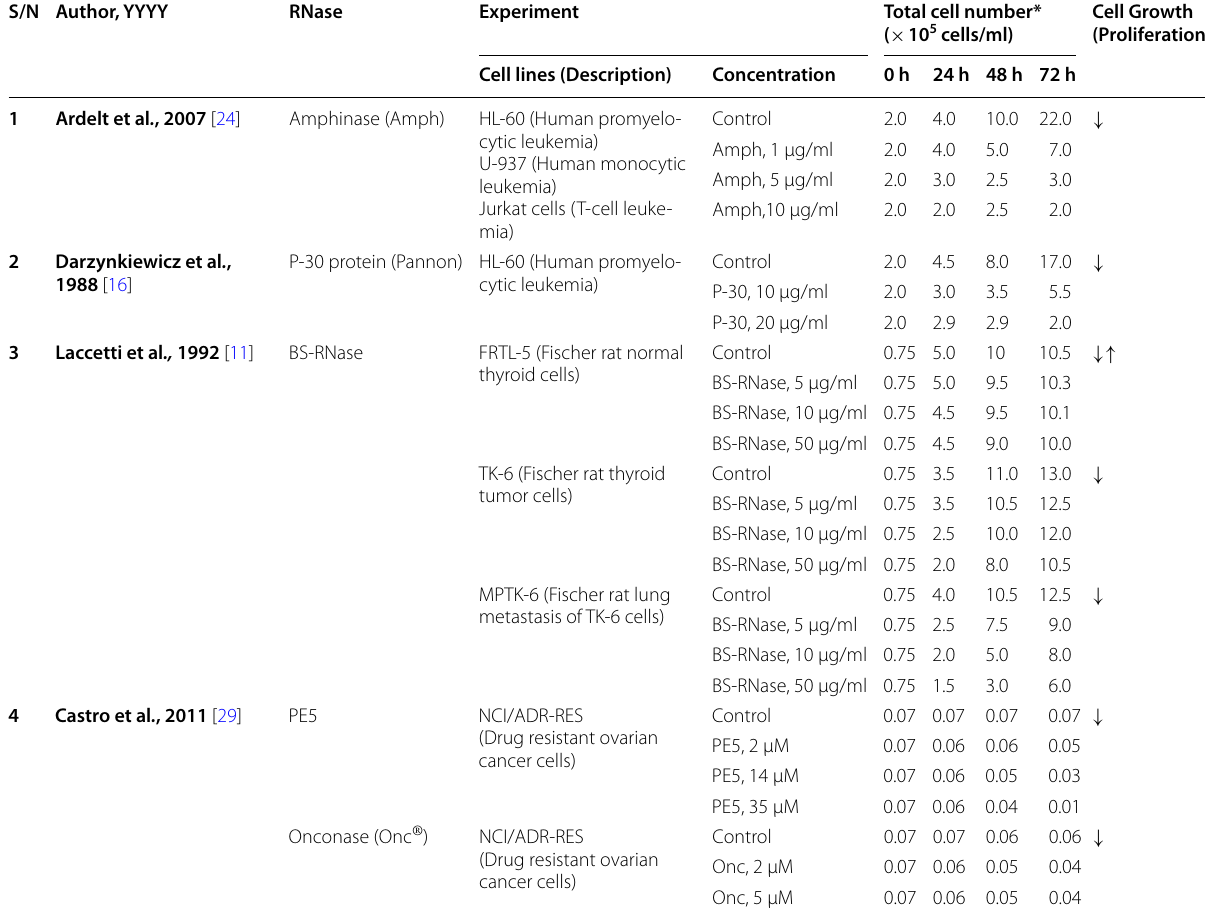
*All values of total cell number are approximate value and extracted from each respective reference. proliferation. balanced cell proliferation i.e no difference between treated and untreated ↓↑